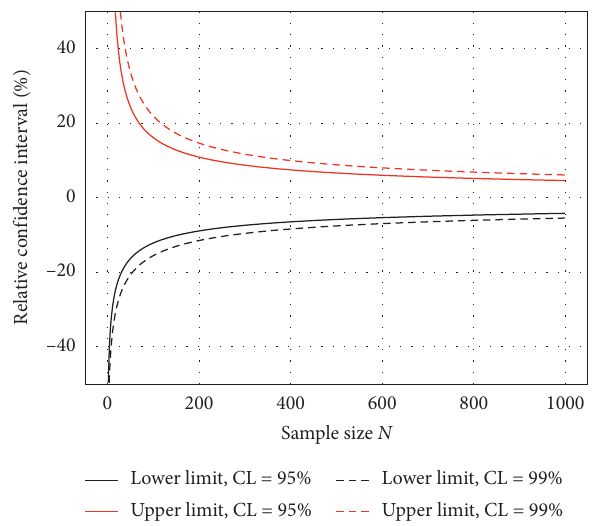
Figure 1: Relative confidence interval for the confidence level of 95% and